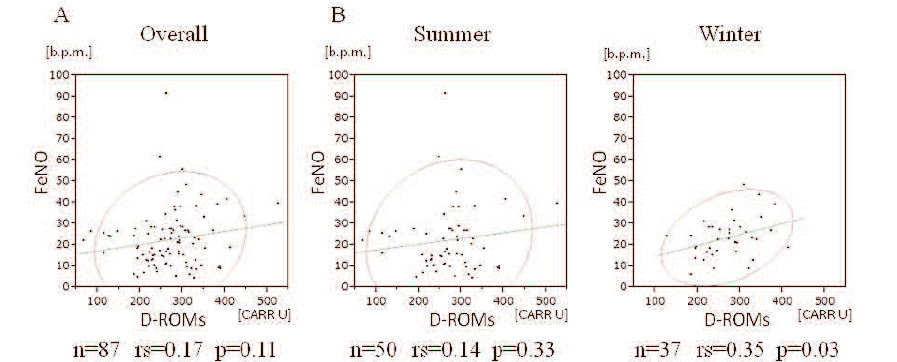
Figure 1.: Correlation of FeNO and d-ROMs tests; (A) Overall FeNO/d-ROMs test correlation during this study; (B) Seasonal variation in FeNO/d-ROMs test correlation Correlation was analyzed separately for summer and winter.